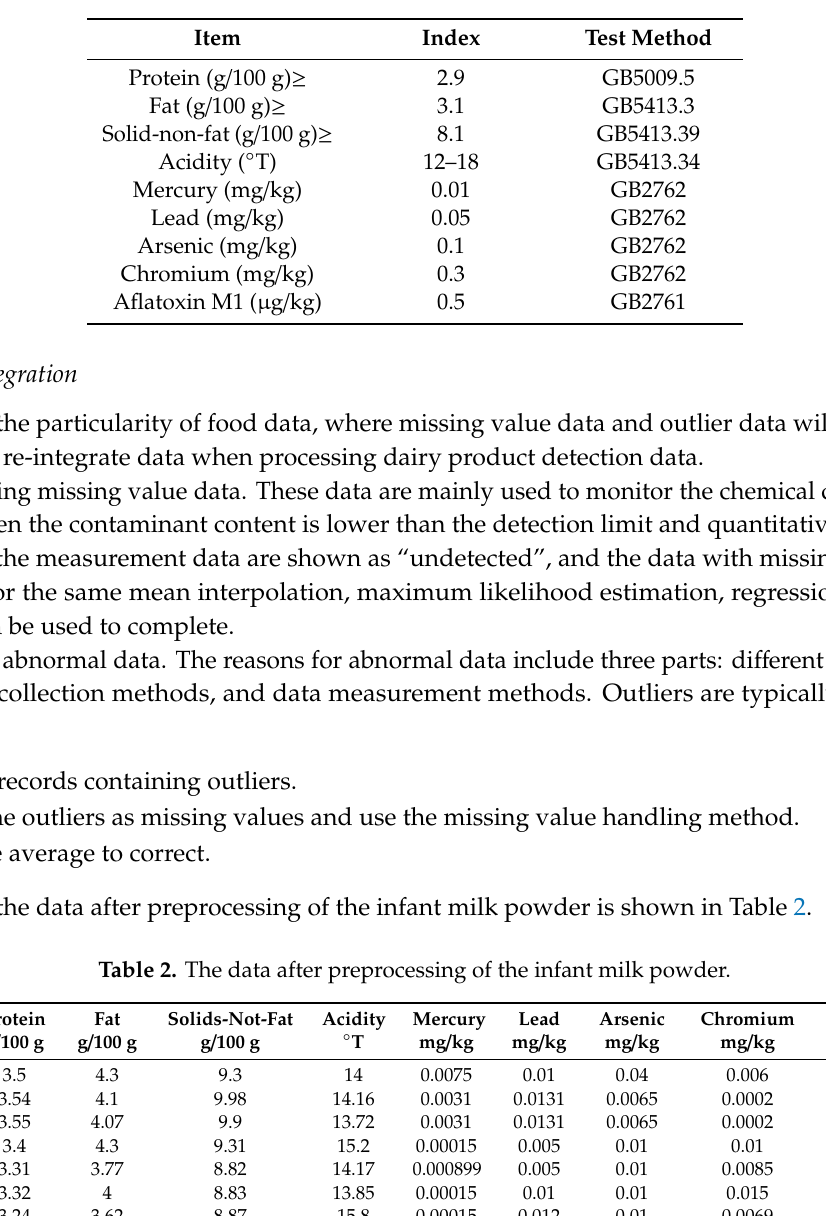
Table 1. The evaluation index of infant milk powders.